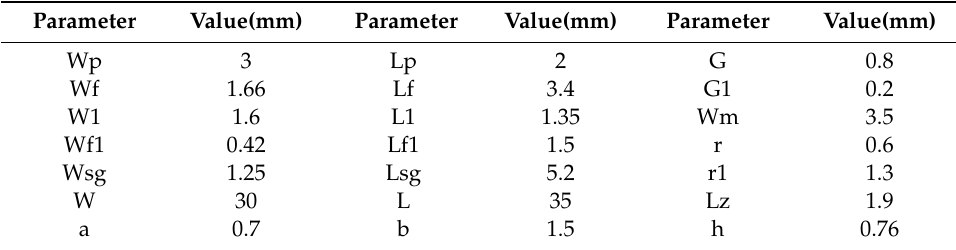
Table 1. Optimized Design Parameters.